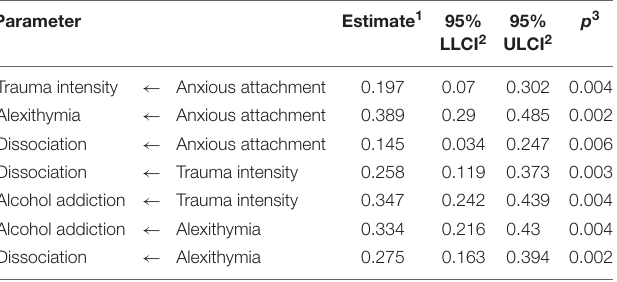
FIGURE 2 | A final graphical model presenting the nature of dependencies between attachment styles and trauma, dissociation, and alexithymia, in explaining an inclination to alcohol addiction risk. Source: Zdankiewicz- ´Scigała (2017).